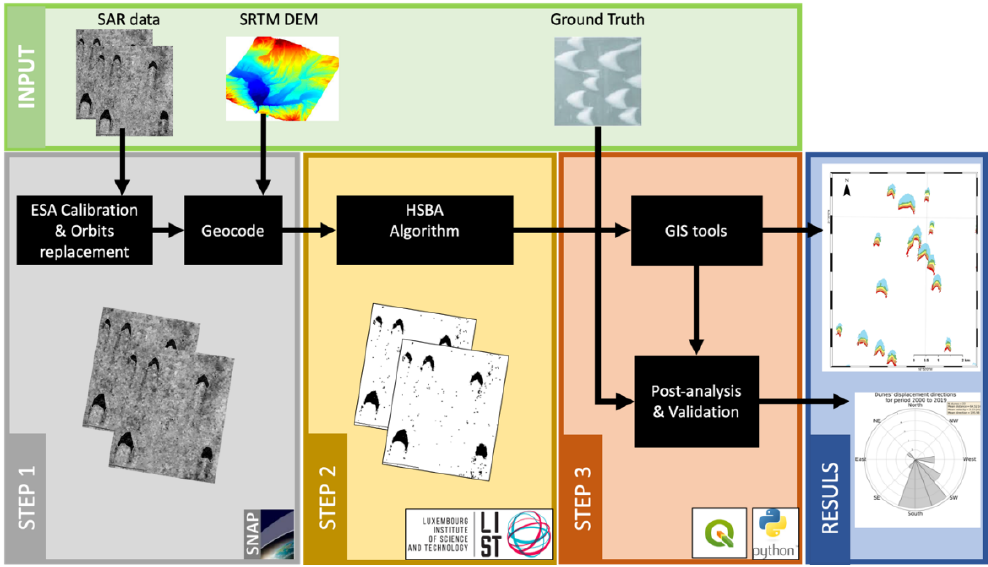
Figure 5. Overview of the methodological approach with the three steps discussed in the text.